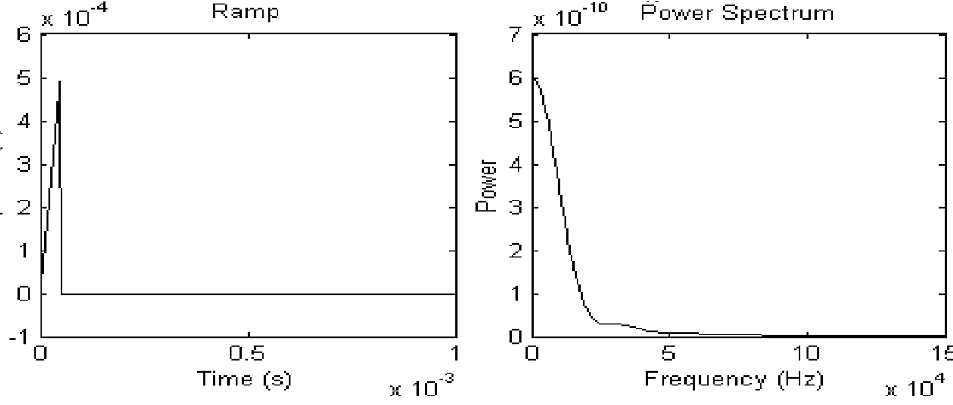
Fig. 7. Square actuation wave – time and frequency domain analysis.